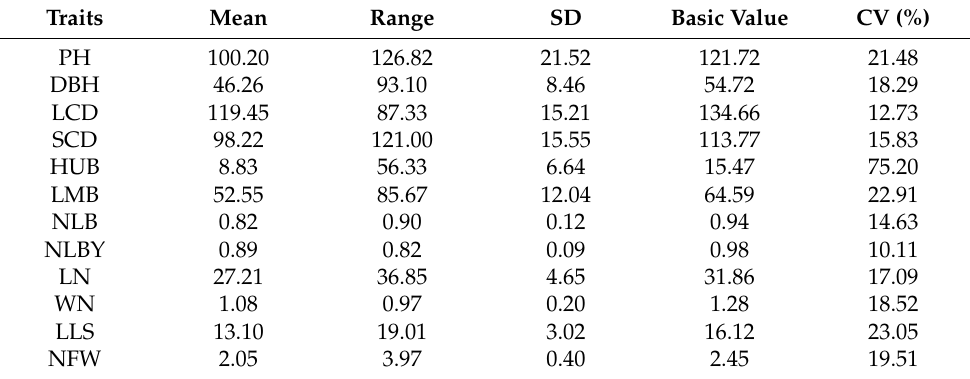
Table 4. Growth performance and form quality performance of each population of P. yunnanensis .